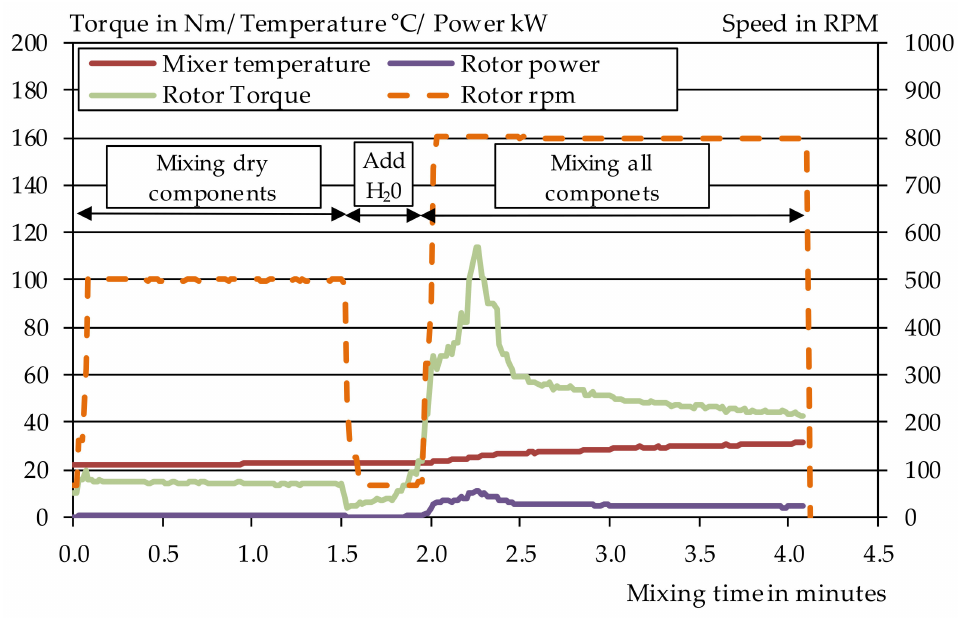
Figure 2. Mixing process of the extruded mortar using the example of Mix